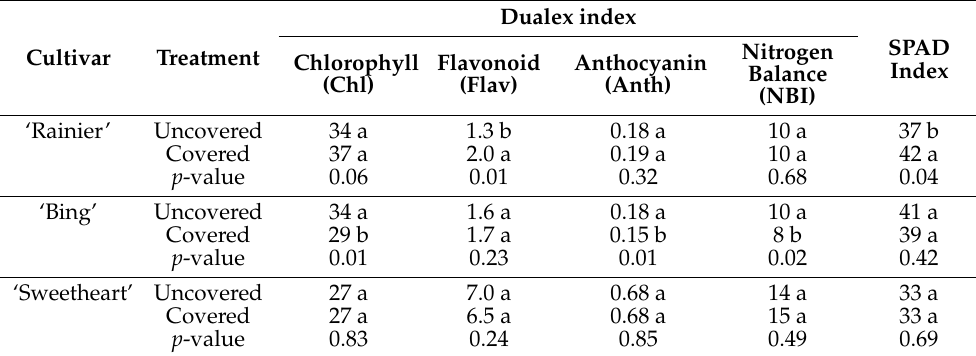
Table 5. Relative pigment content in leaves of ‘Rainier’, ‘Bing’ and ‘Sweetheart’ sweet cherry trees with and without rain